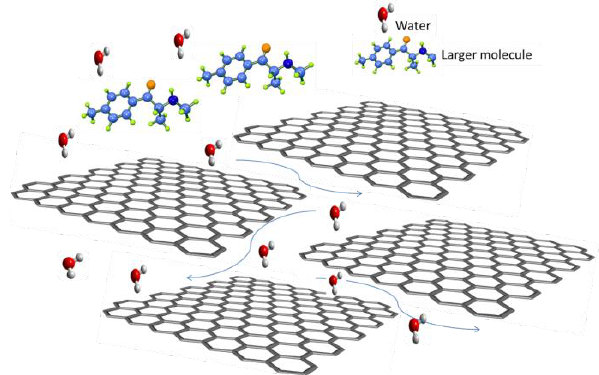
Figure 3. Transport in GO stacked layers.